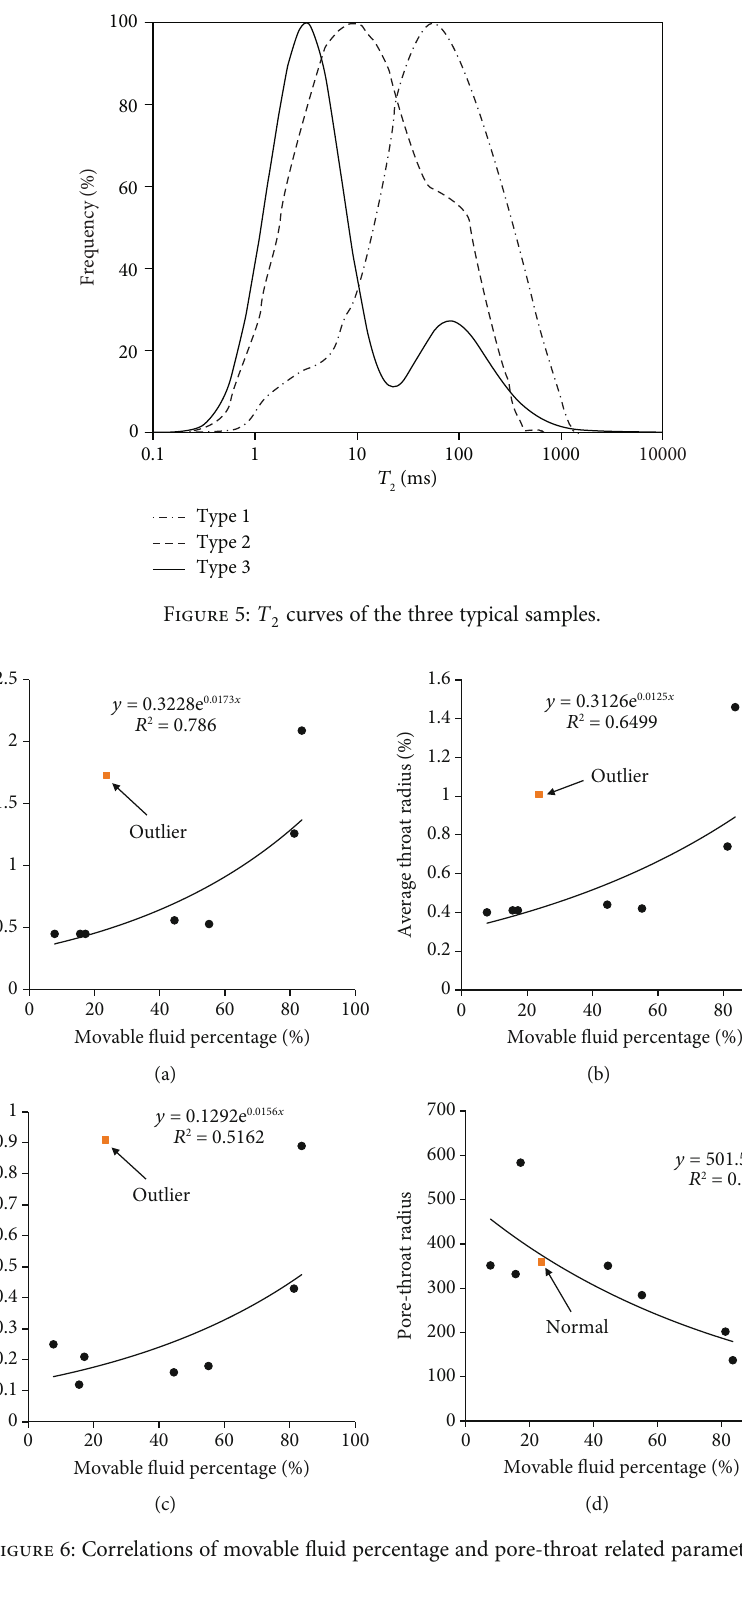
Figure 6: Correlations of movable fl uid percentage and pore-throat related